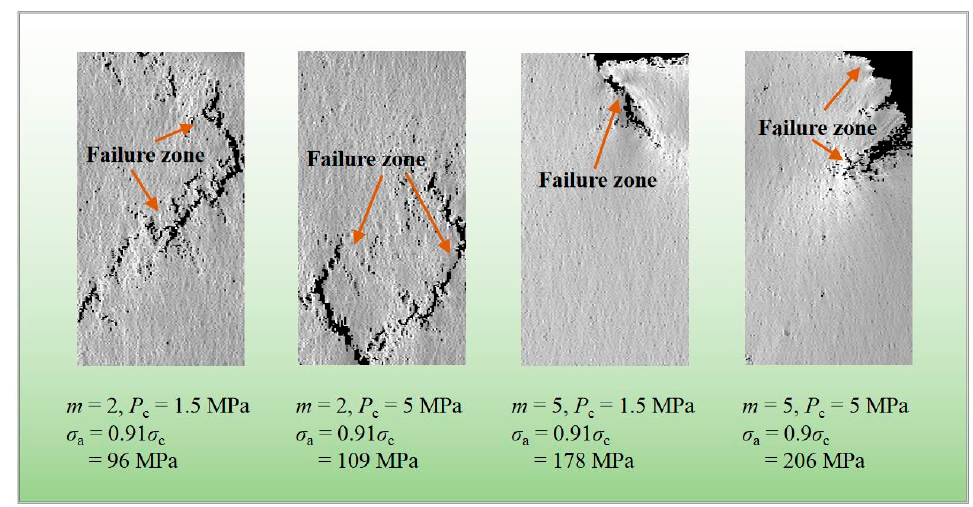
Figure 19. Damage accumulation at the last stress level for various homogeneity indexes during triaxial creep loading.